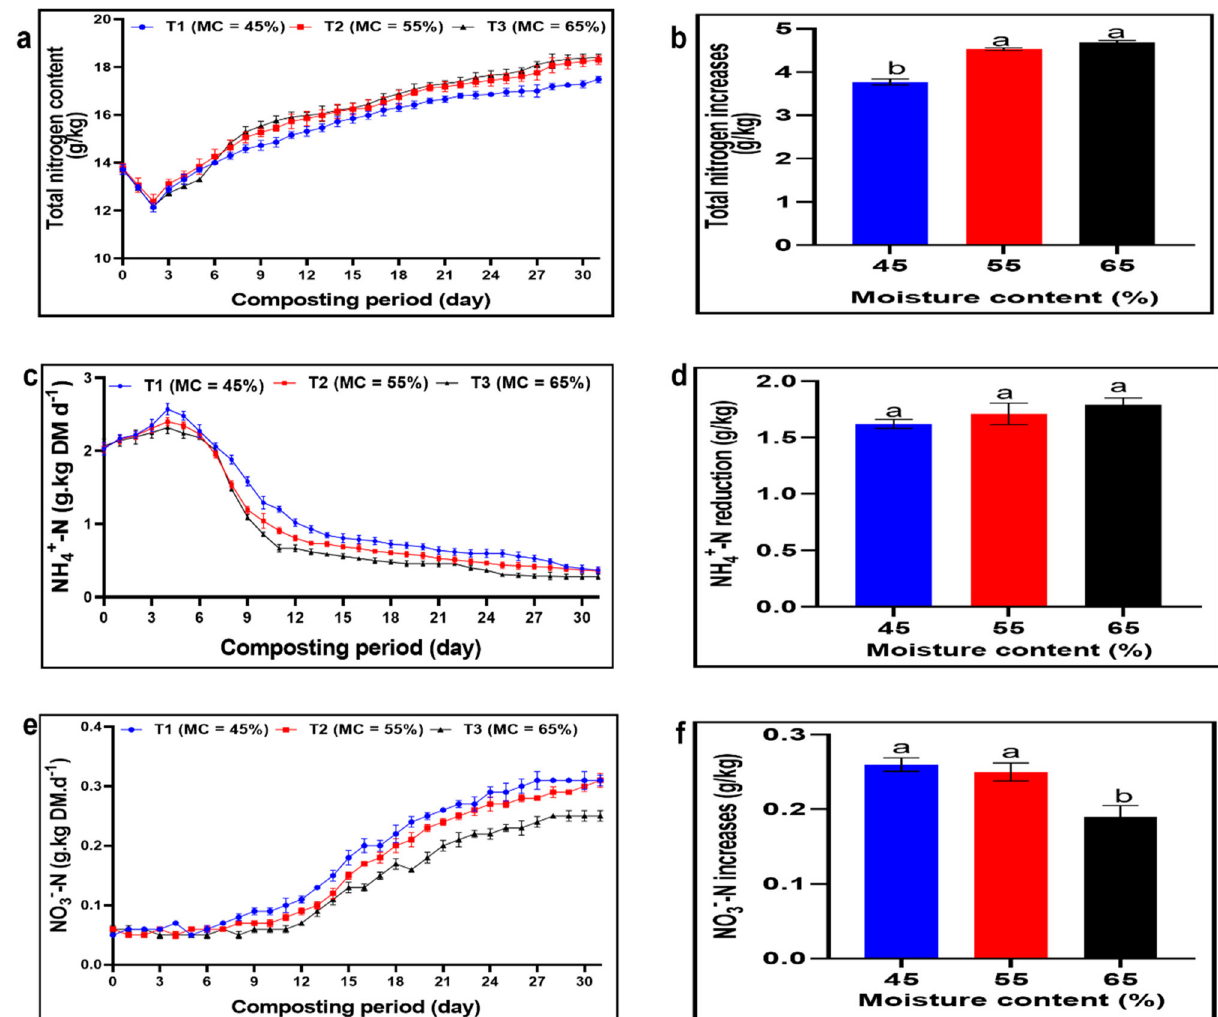
Figure 4. Temporal evolution of total nitrogen ( a , b ), ammonium nitrogen ( c , d ) and nitrate nitrogen ( e , f ) during composting under different moisture